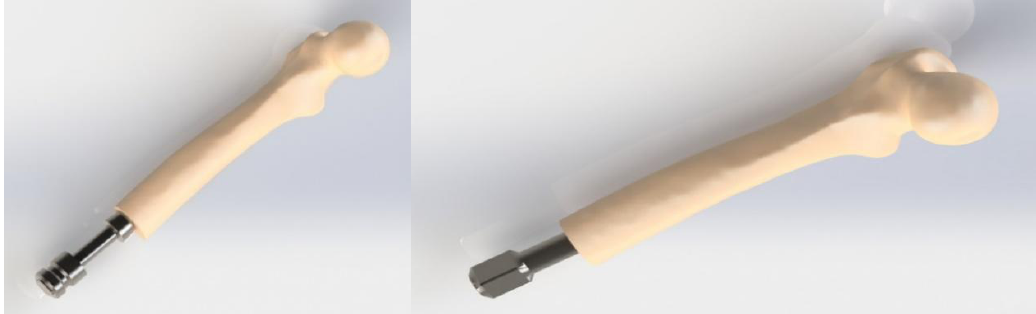
Figure 6. CAD models of the implant/bone assemblies: OPL (on the left ) and OPRA (on the right ).